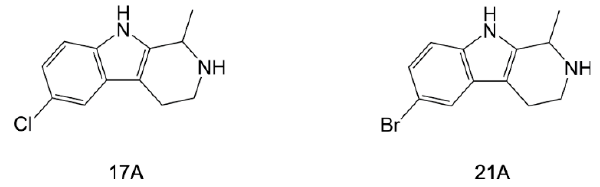
Figure 9. Chemical structures of 17A and 21A [108].